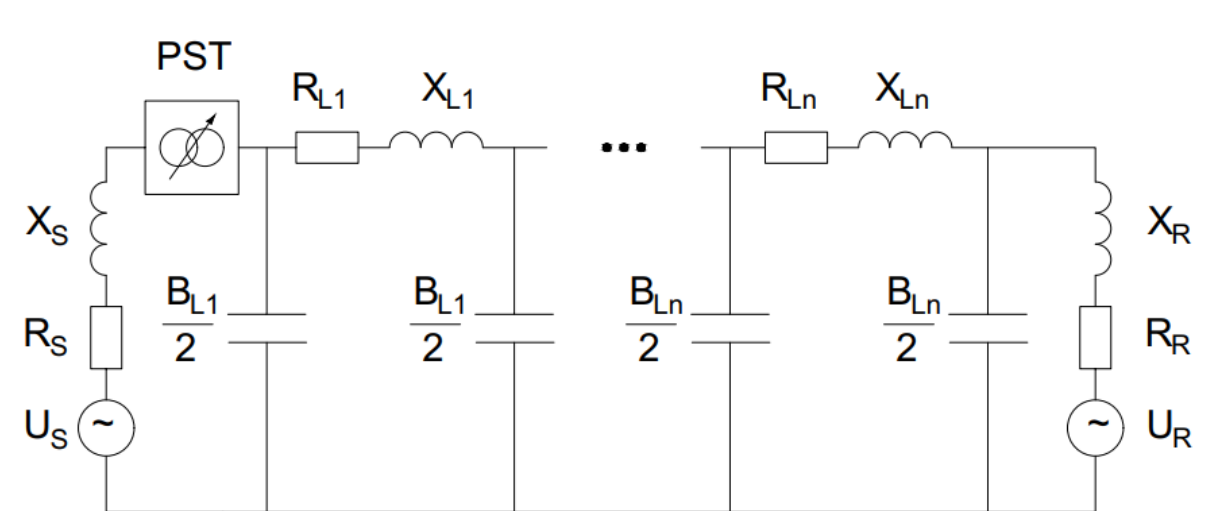
Figure 9. The laboratory system connection scheme .